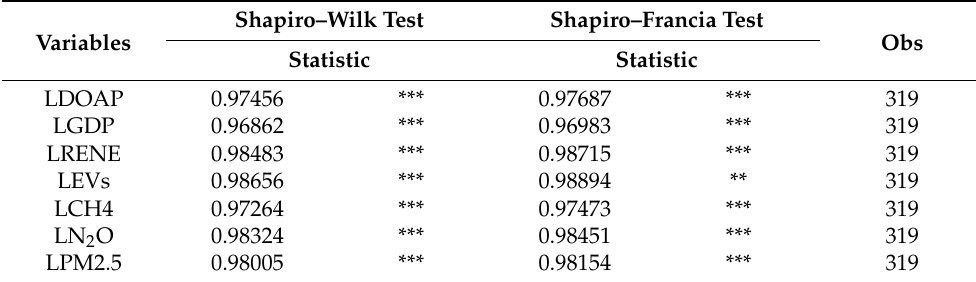
Table 4. Normal distribution tests.